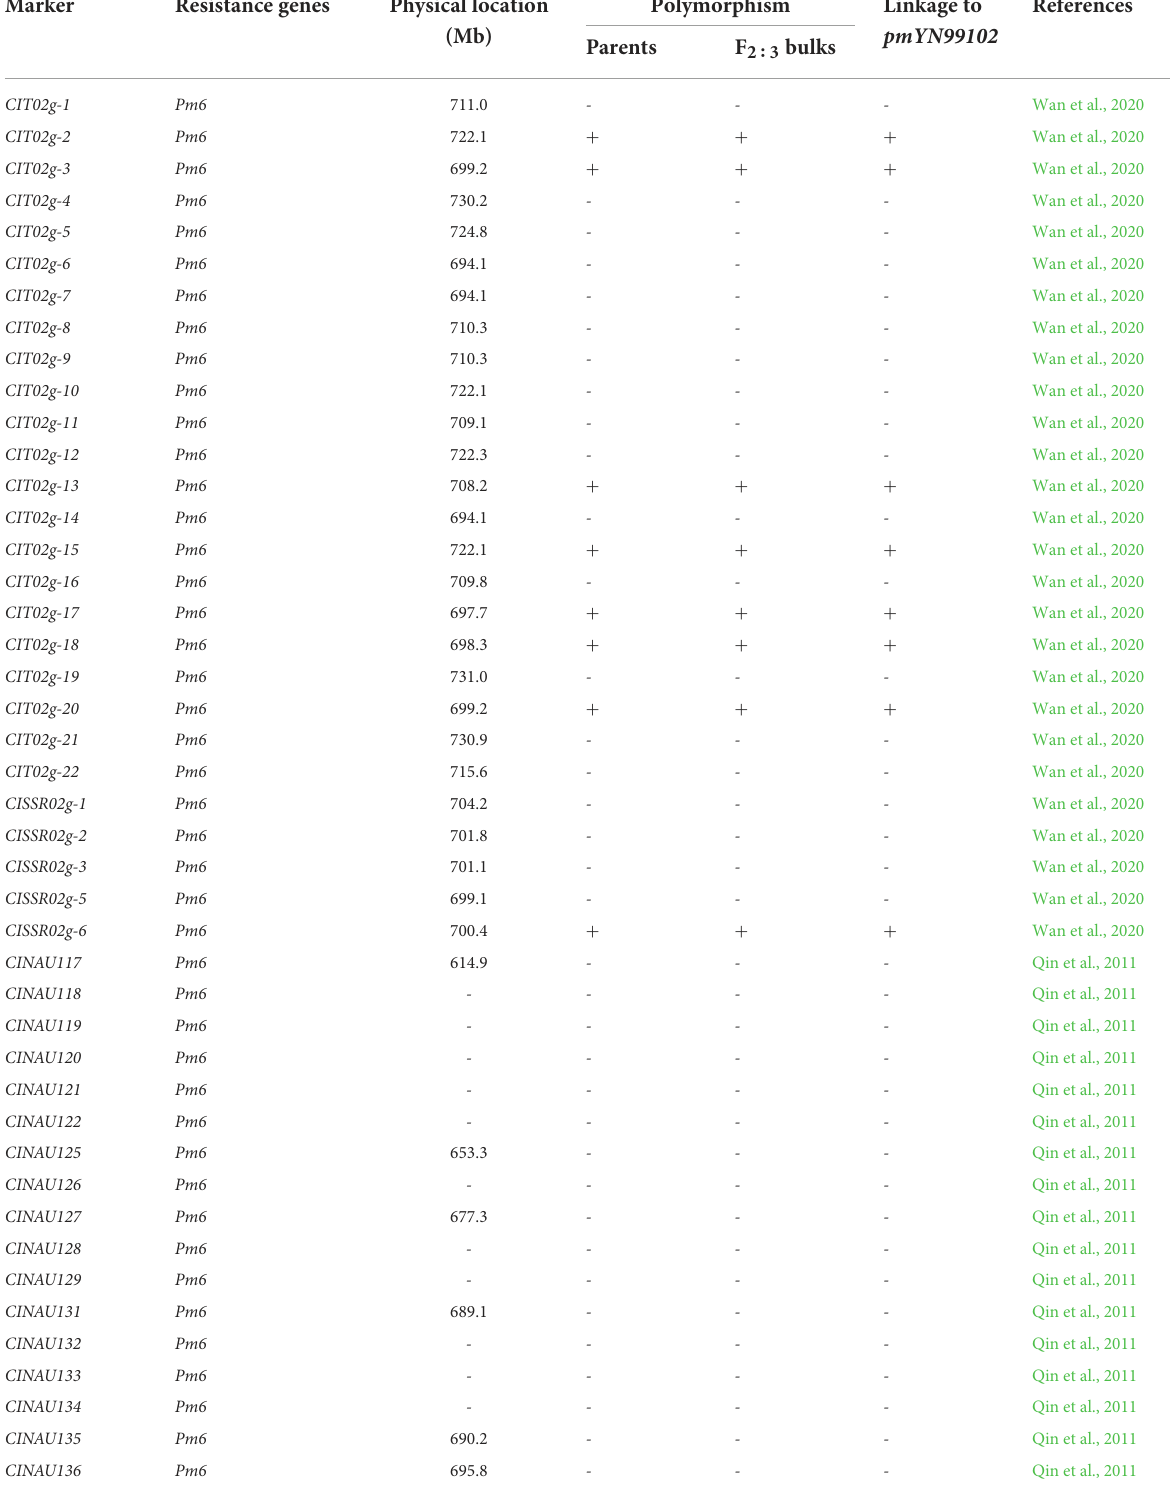
TABLE 2 Polymorphic and linkage analyses of the markers linked to the powdery mildew resistance genes located on chromosome arm 2BL using the mapping population derived from the cross of Yannong 99102-06188 × Jinhe 13–205.